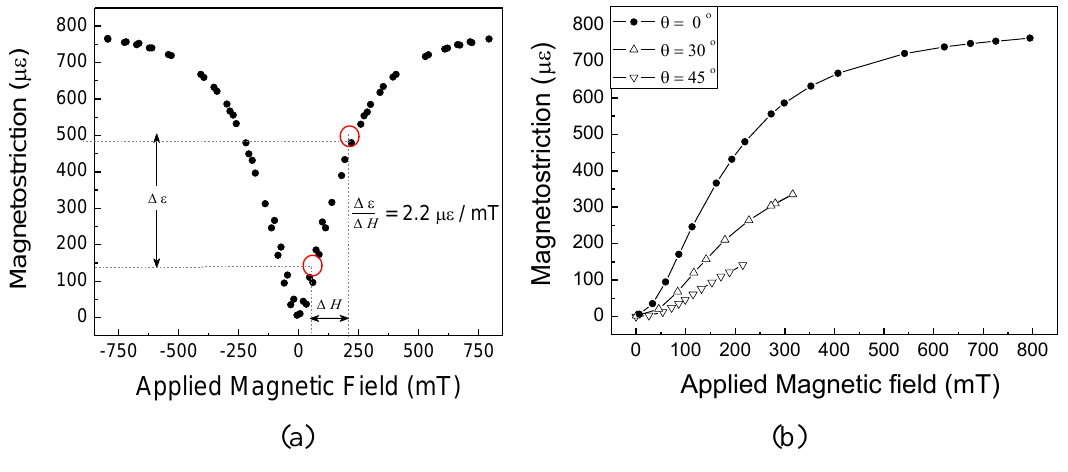
Figure 6. (a) Comparison of sensor response with and without a compressive preload. In both cases, results are for sensor with length of 7 mm and 1.5 mm diameter. (b) Load cell developed to apply the